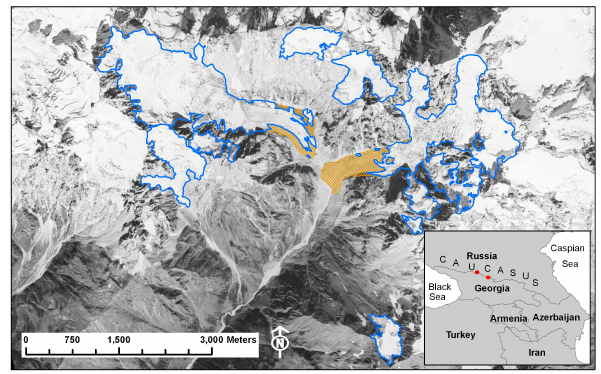
Fig. 2. CORONA image from September 1971 for the Zopkhito basin with the boundaries of all glaciers and the supra-glacial debris cover of the Zopkhito and Laboda Glaciers